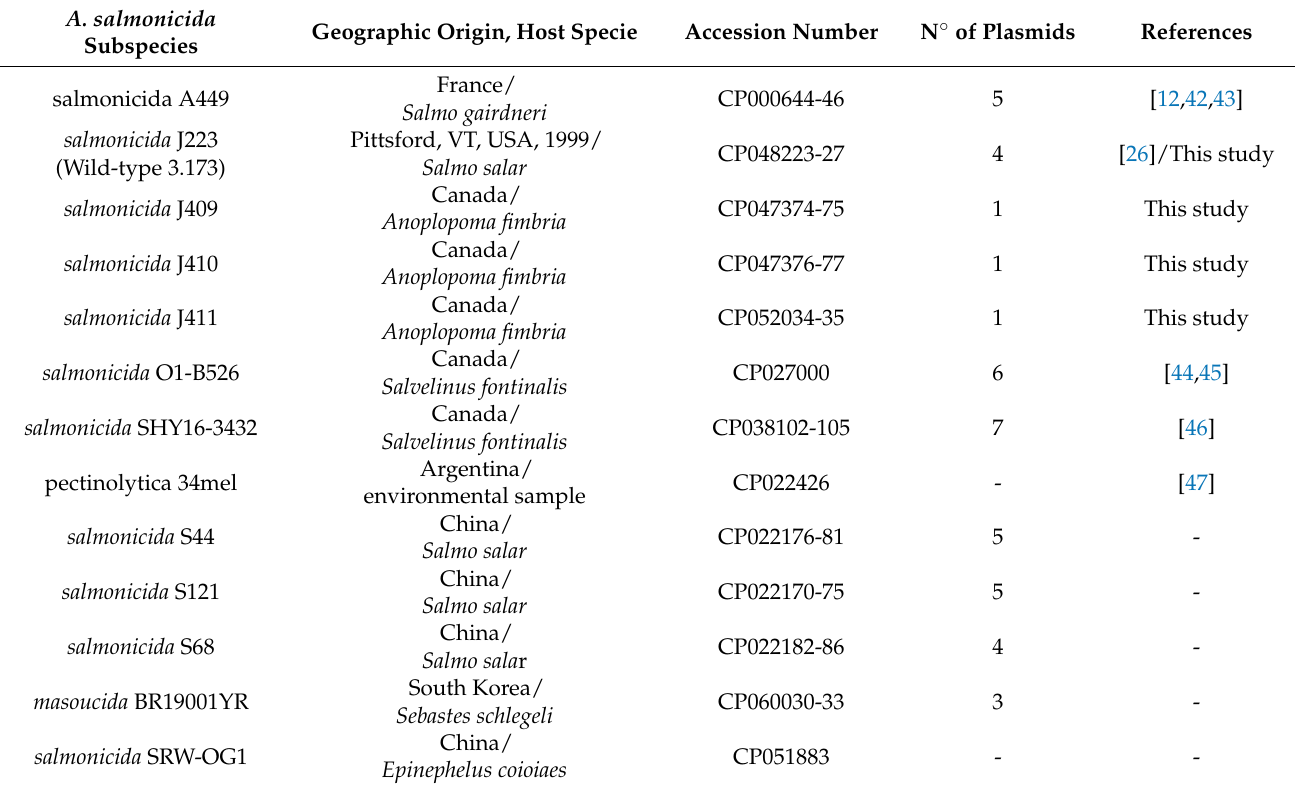
Table 1. Geographic origin and host species of A. salmonicida